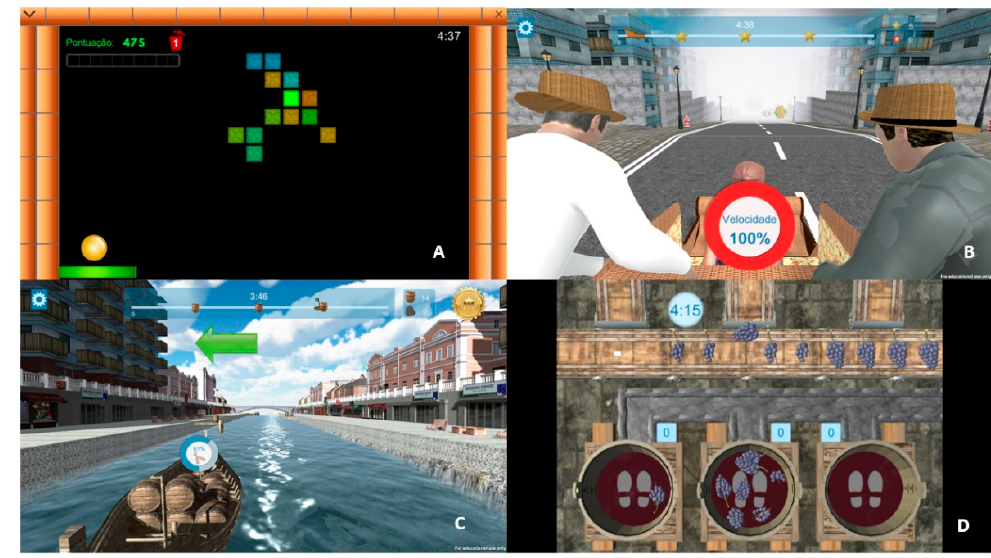
Figure 2. Different games on the Portable Exergame Platform for Elderly. ( A ) Exerpong; ( B ) Toboggan games; ( C ) Rabelos; ( D ) Grape stomping.